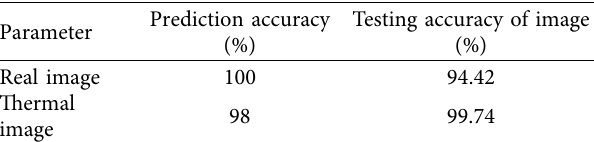
Table 9: Prediction and testing accuracy of real and thermal